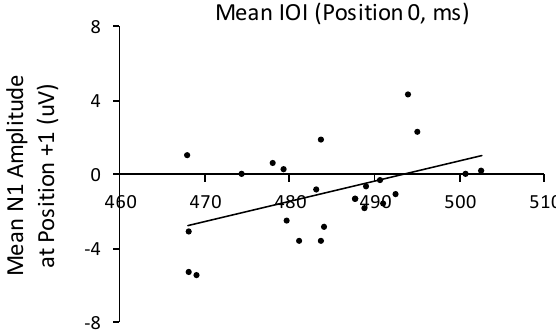
Figure 8. Correlation of mean IOIs at target event position 0 in the future +1 altered feedback condition with mean N1 amplitudes elicited by the tone that followed the altered auditory feedback pitch in the future +1 condition. Each dot represents one participant.